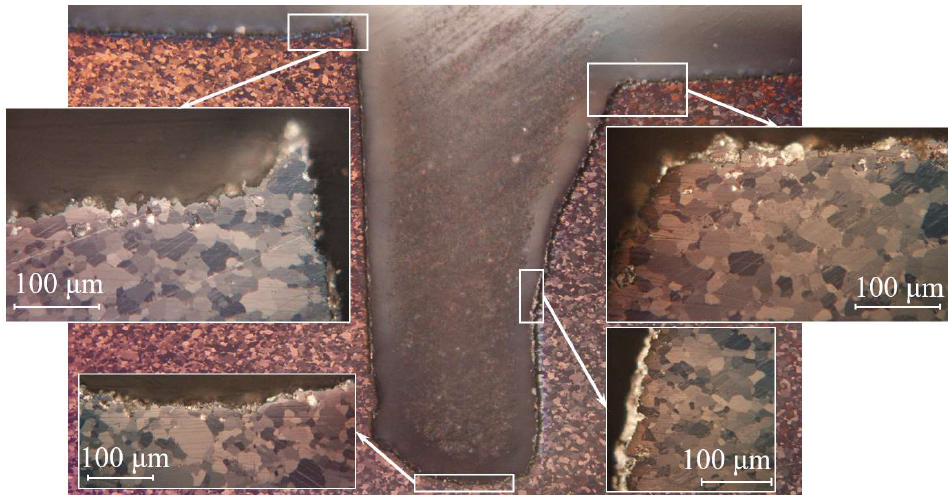
Figure 14. Microstructure of the Be-6 sample cross section (1200 ◦ C, 100 cycles). Moreover, in a certain area of the notch, a decrease in the width of the notch from 1.00 mm to 0.77 mm was found. This effect is due to the reprecipitation of beryllium particles eroded from the surface; since at a beryllium temperature above 1000 K, there is a significant increase in erosion due to thermal evaporation. The surface of sample Be-6 is similar to that of sample Be-3: deep pores (channels) are also present; however, in this case, their concentration is higher and the pore diameter reaches 30 µ m (see Figure 15). On the surface, there is a clear change in shape in the form of a depression and darkening in the central part of the sample.